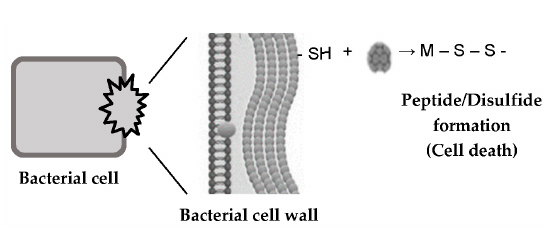
Figure 7. Bacterial growth after treatment with different synthesized CuI NPs for each bacterial strains: ( a ) E. coli treated with CuI; ( b ) MRSA treated with CuI; ( c ) E. coli treated with 2.5 GA-CuI; Figure 8. Antibacterial mechanism of CuI NPs through denaturation. ( d ) MRSA treated with 2.5 GA-CuI; ( e ) E. coli treated with 5.0 GA-CuI; ( f ) MRSA treated with 5.0 GA-CuI.